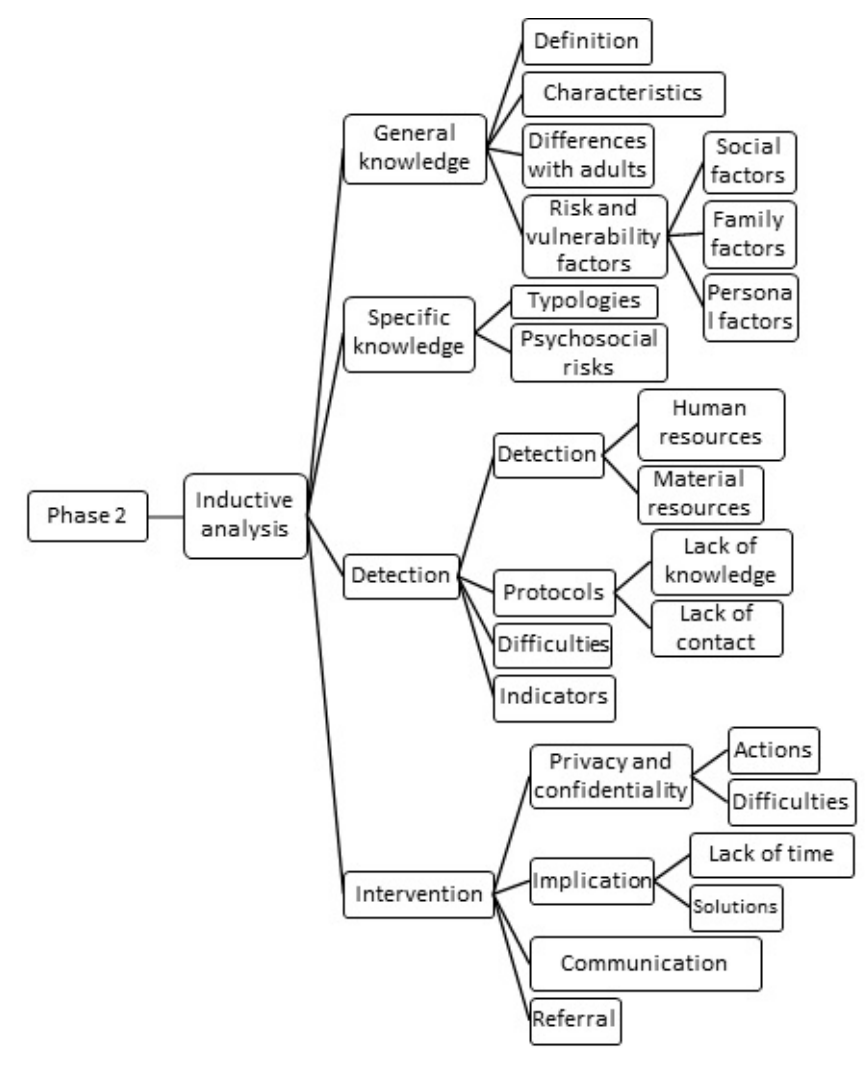
Figure 2. Second phase of the analysis.